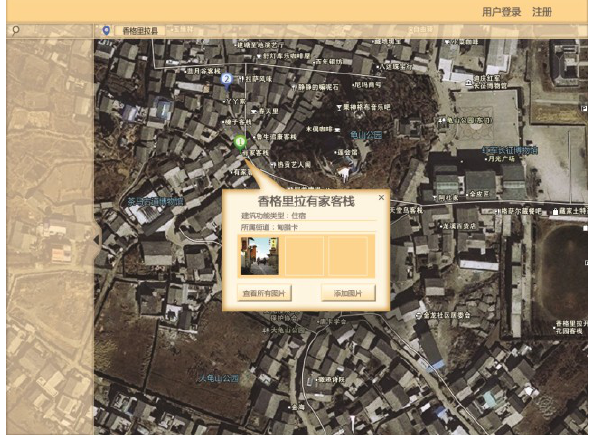
Figure 6. Re-Shangrila Interactive Map